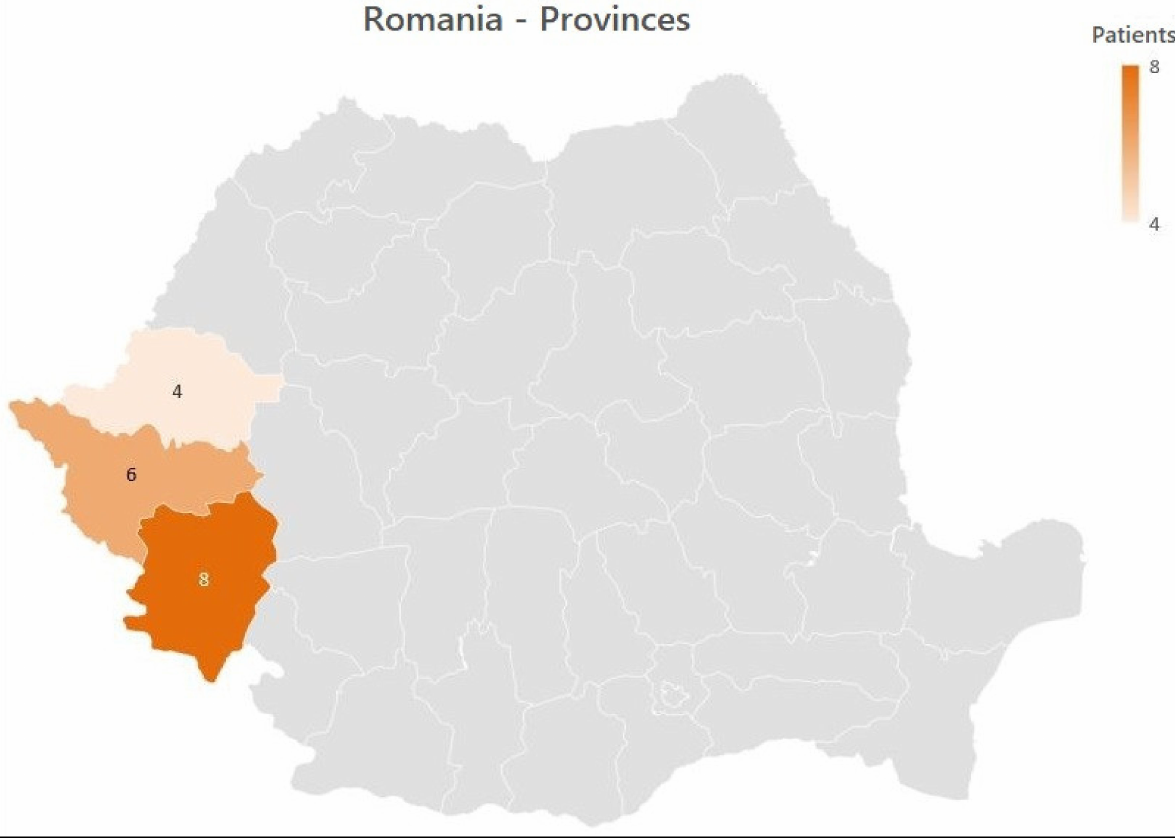
Figure 2. Case distribution by